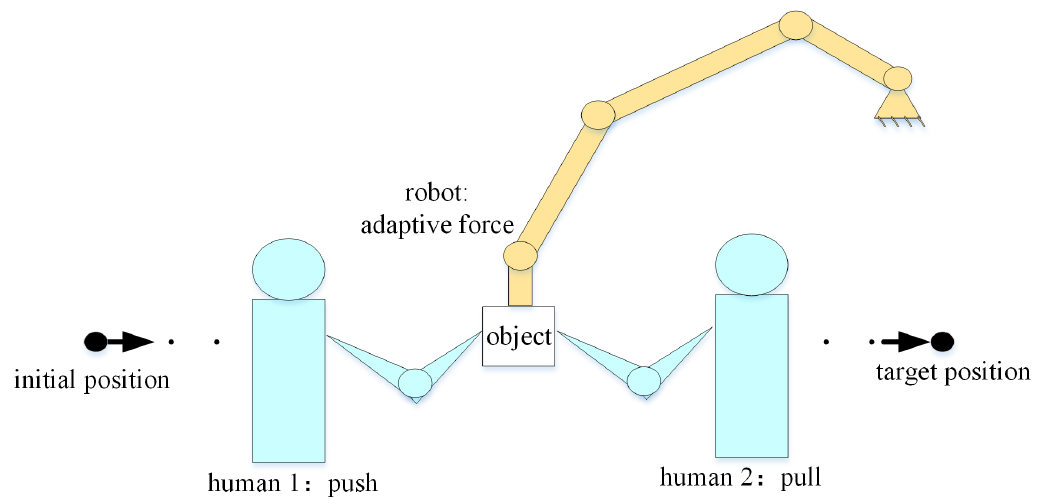
Figure 1. A scenario where the humans and the robot collaborate to perform an object transporting